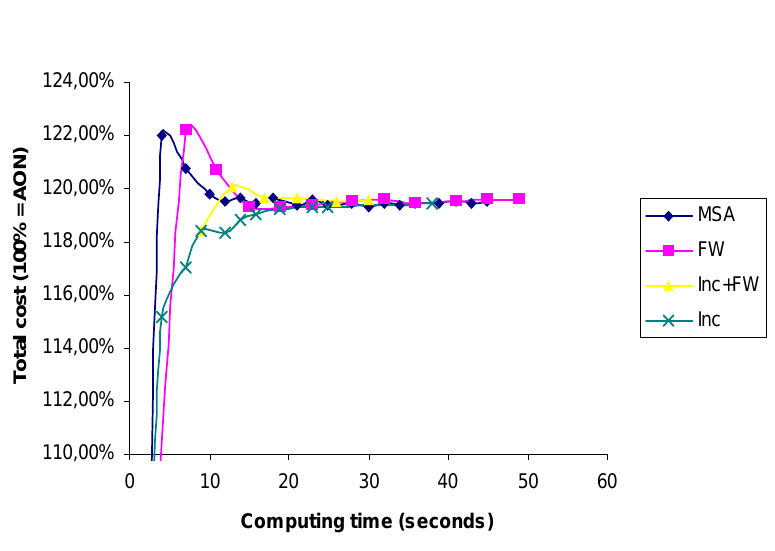
Figure 7. Assignment results on a congested artificial